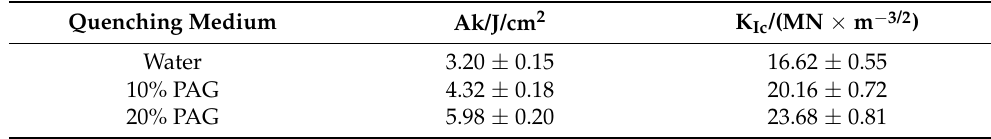
Table 5. Influence of quenching medium on the toughness of high chromium cast iron. Quenching